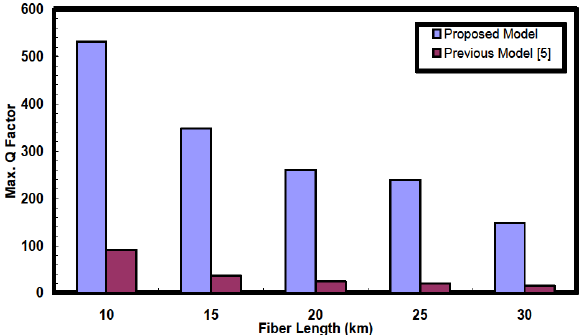
Figure 2: Max Q-factor versus cable length as per the previous and proposed